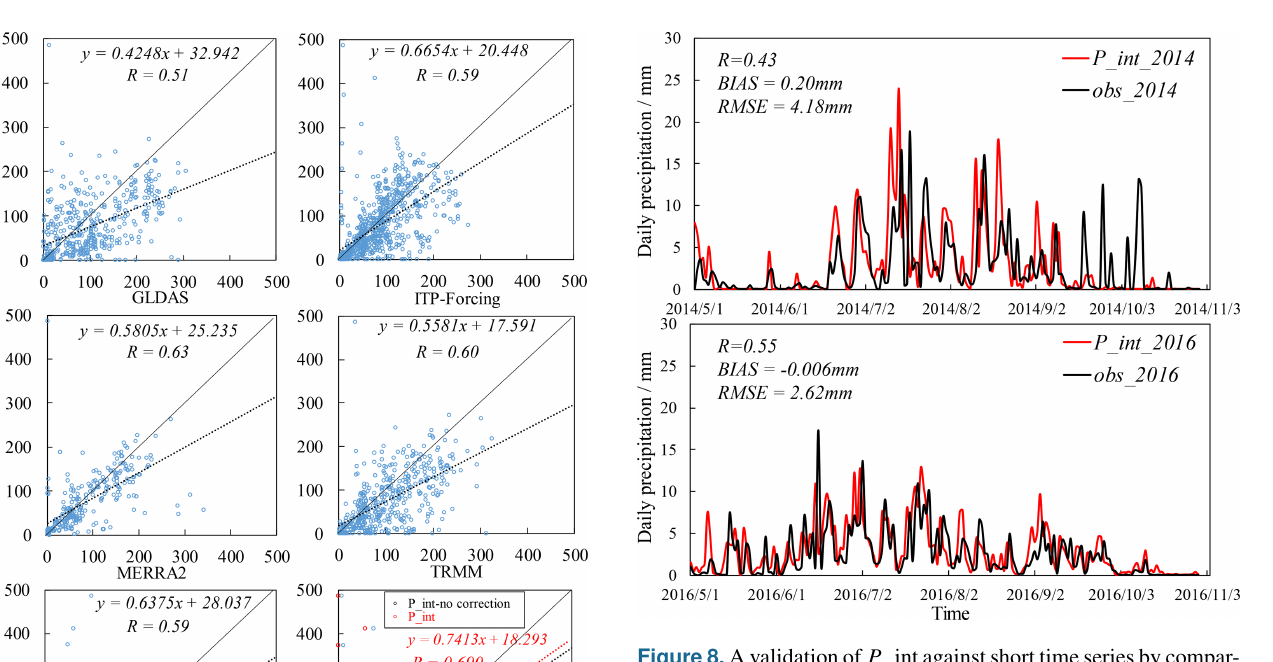
Figure 8. A validation of P _int against short time series by compar- ing with daily gauge-averaged precipitation from May to October in 2014 and